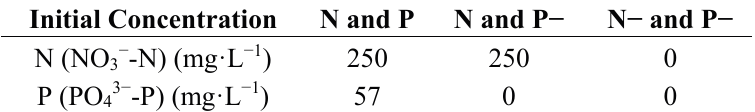
Table 1. The initial concentrations of nitrate and orthophosphate for three types of culture media. Initial